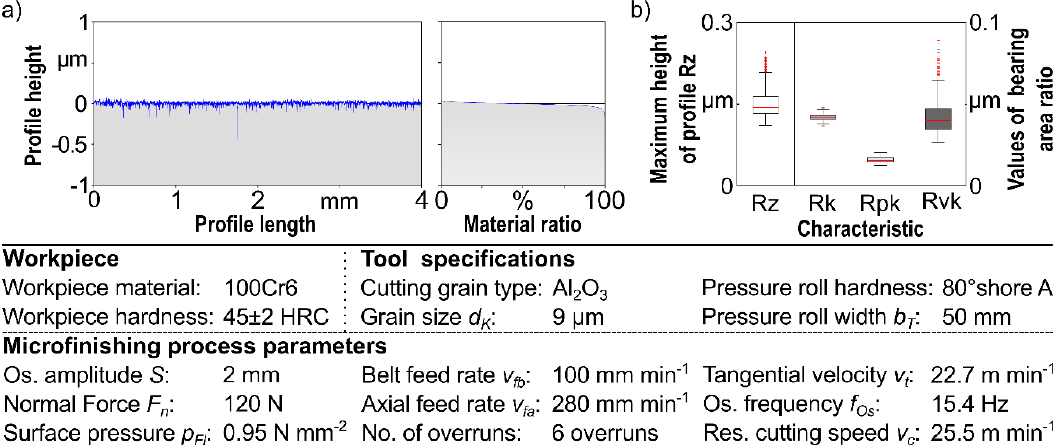
Figure 5. Resulting surface for the first fine microfinishing step by means of ( a ) the profile and material ratio curve and ( b ) surface values.